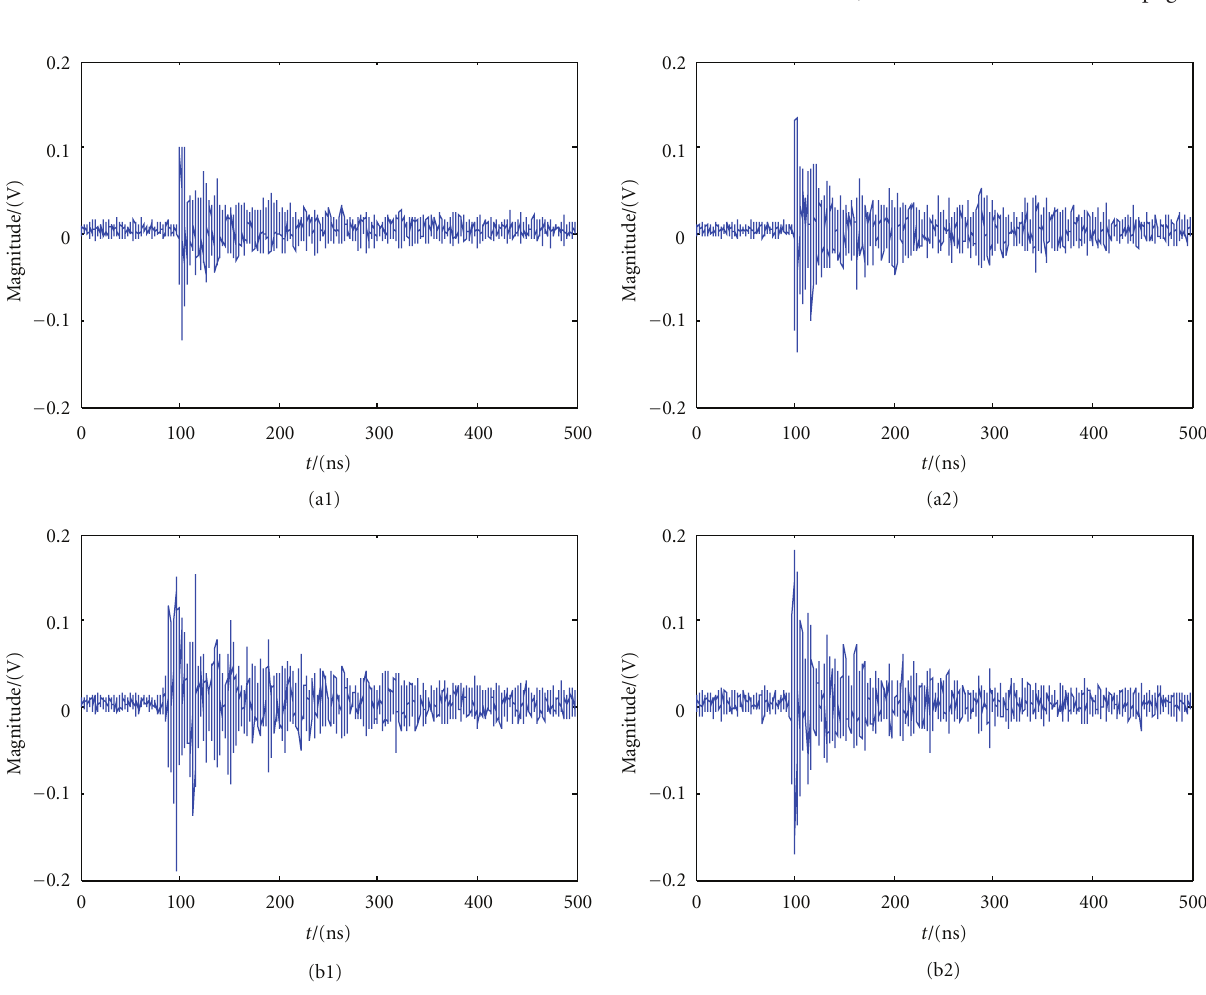
Figure 11: Waveforms of UHF PD signals from the two defects: (a) signals from corona and surface models detected by Hilbert antenna; (b) signals from corona and surface models detected by Peano antenna.